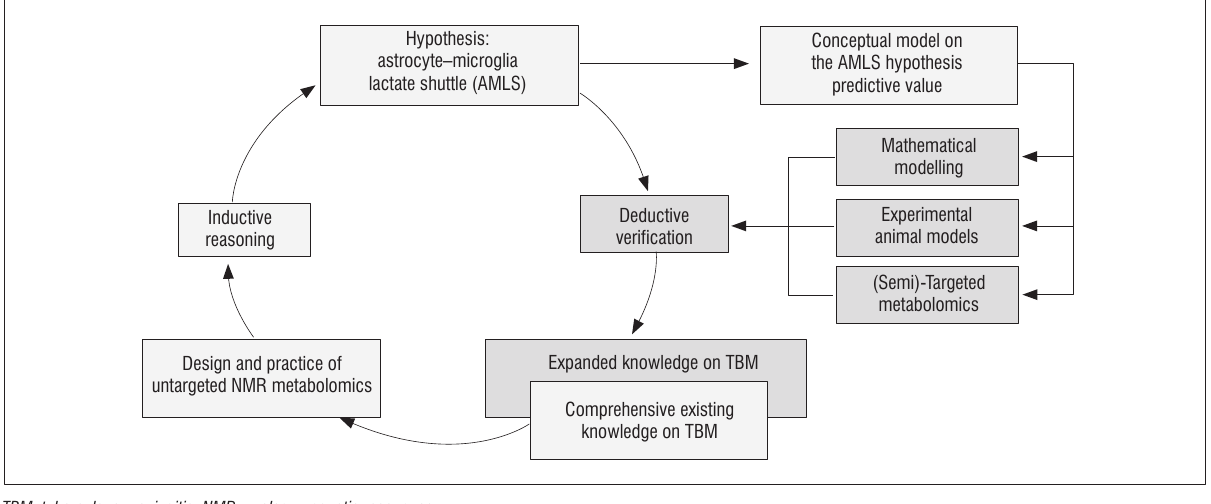
Iterative cycle of knowledge, using the astrocyte–microglia lactate shuttle (AMLS) hypothesis as an example. The existing knowledge forms the basis of inductive reasoning that leads to the formulation of hypotheses, which in turn is followed by the use of deduction to verify these hypotheses and to further existing